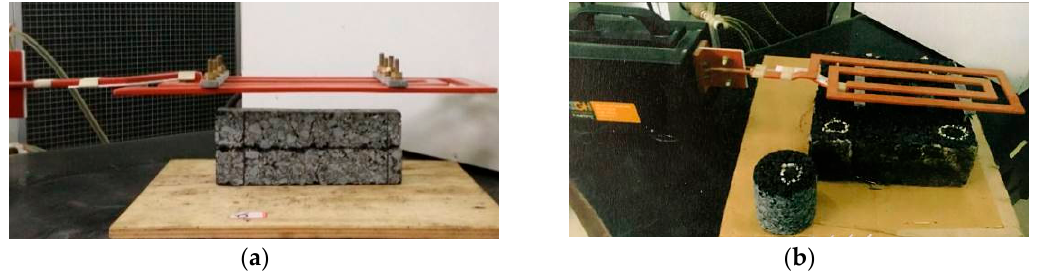
Figure 1. Induction heating of the sample: ( a ) hearing beam, ( b ) heating slab.